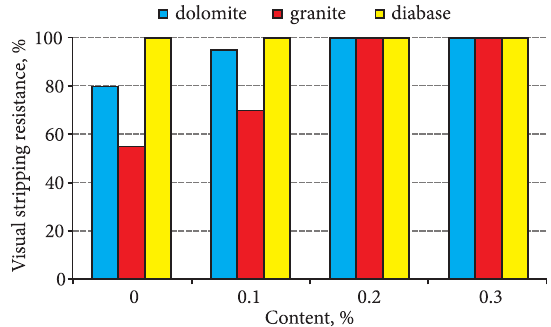
Fig. 1. Stripping resistance with bitumen B70/100 form Orlean Lithuania containing polyphosphoric acid based liquid